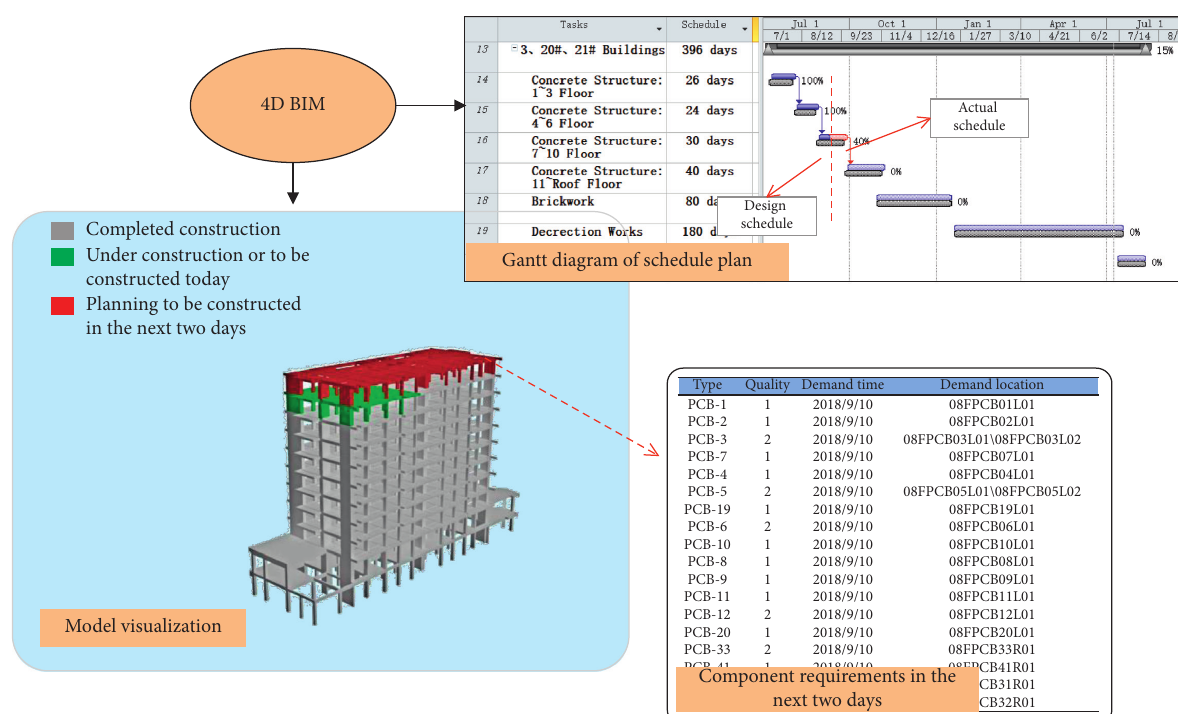
Figure 10: 4D BIM of the demonstration project.